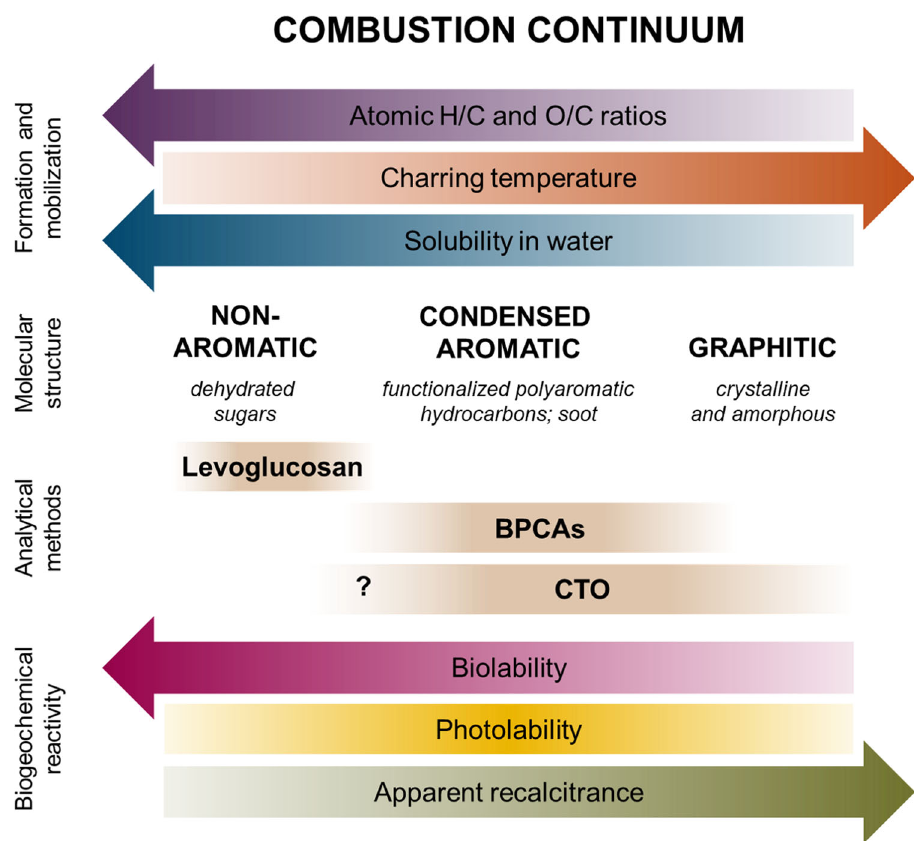
Fig. 1 The theoretical combustion continuum. The combustion continuum ranges from mildly thermally altered biomolecules to highly condensed and graphitic structures and describes the formation, composition, and reactivity of different carbon fractions. Arrows indicate the direction of increase. Peak photolability is expected for the condensed aromatic fraction of dissolved black carbon (DBC). The presumed analytical windows for levoglucosan, benzenepolycarboxylic acid (BPCAs), and chemothermal oxidation (CTO) methods are also shown. Data in Qi et al. (2020) suggest CTO captures more than just graphitic DBC, therefore we have expanded the range for this method and included a question mark to denote that further research is needed to understand the breadth of this DBC